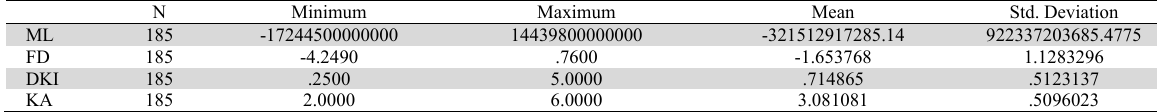
The results of some basic